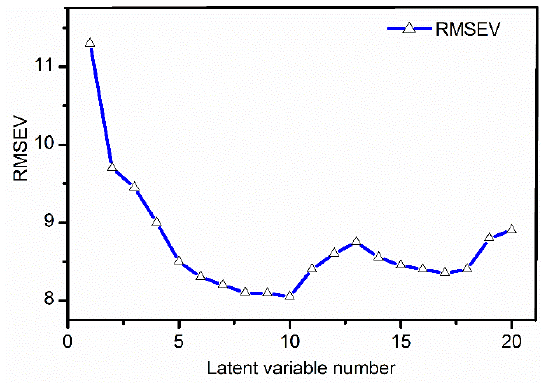
Figure 6. Root-mean-square error (RMSEV) of the prediction model constructed using the latent